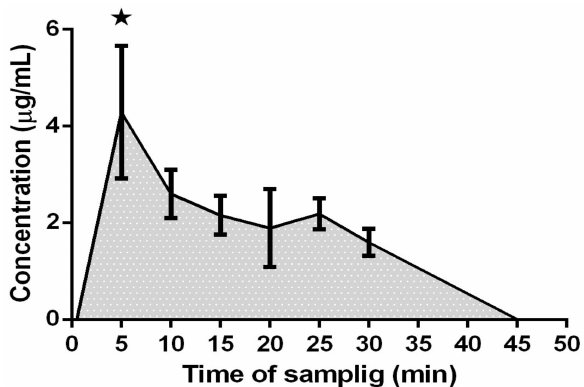
Figure 2. Galangine–glucuronide concentration in plasma samples collected at different times is shown: after 5 min this metabolite reaches its highest concentration in plasma; then, the concentration maintains a plateau; finally, after 45 min from the treatment, it is no longer detectable. Asterisk indicates significantly different from the other time points ( p <